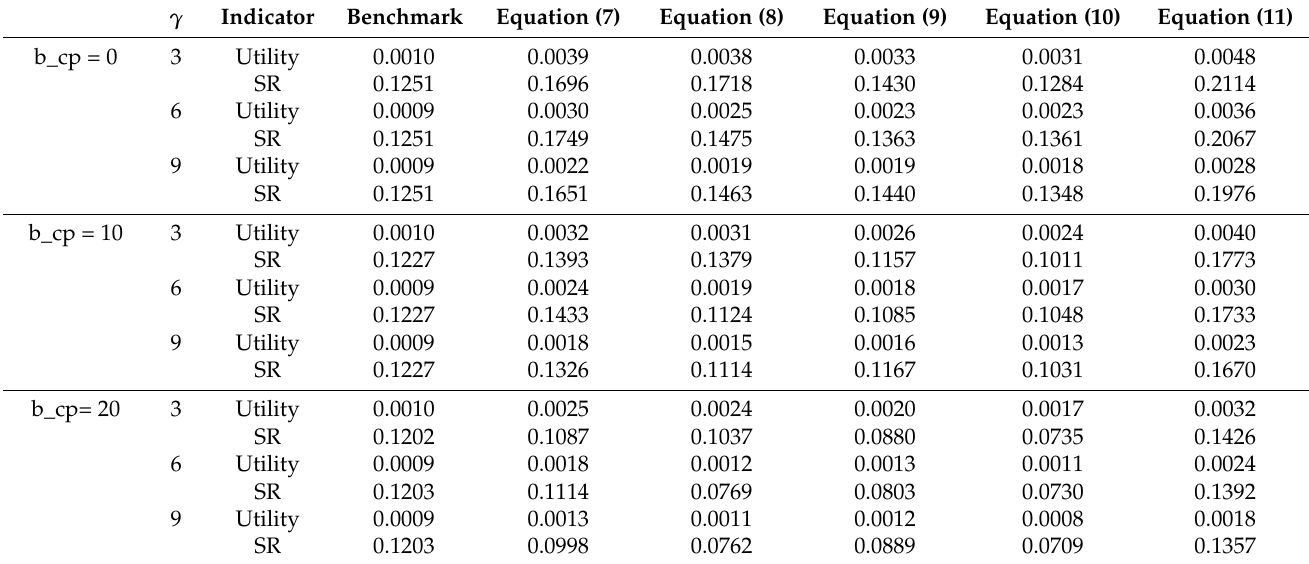
Table 10. Economic values of incorporating investor